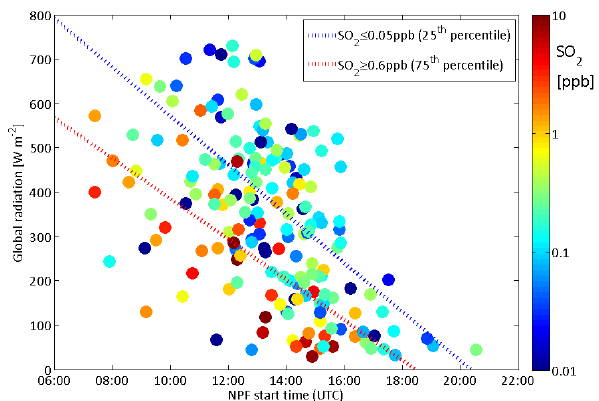
Fig. 11. NPF start time (UTC) as a function of global radiation and Figure 11 NPF start time (UTC) as a function of global radiation and sulphur dioxide 5 sulfur dioxide concentration (colour bar). Both are mean values 1h concentration (colorbar). Both are mean values one hour before and after the start of NPF. 6 before and after the start of NPF. Linear fits for data when SO 2 Linear fits for data when SO 2 concentration is less than 0.05 ppb or more than 0.5 ppb are 7 concentration is less than 0.05ppb or more than 0.5ppb are shown shown with blue and red dashed lines, respectively. These values are the 25 th and 75 th 8 with blue and red dashed lines, respectively. These values are the percentile of SO 2 event-time concentration. 9 25th and 75th percentile of SO 2 event-time concentration.